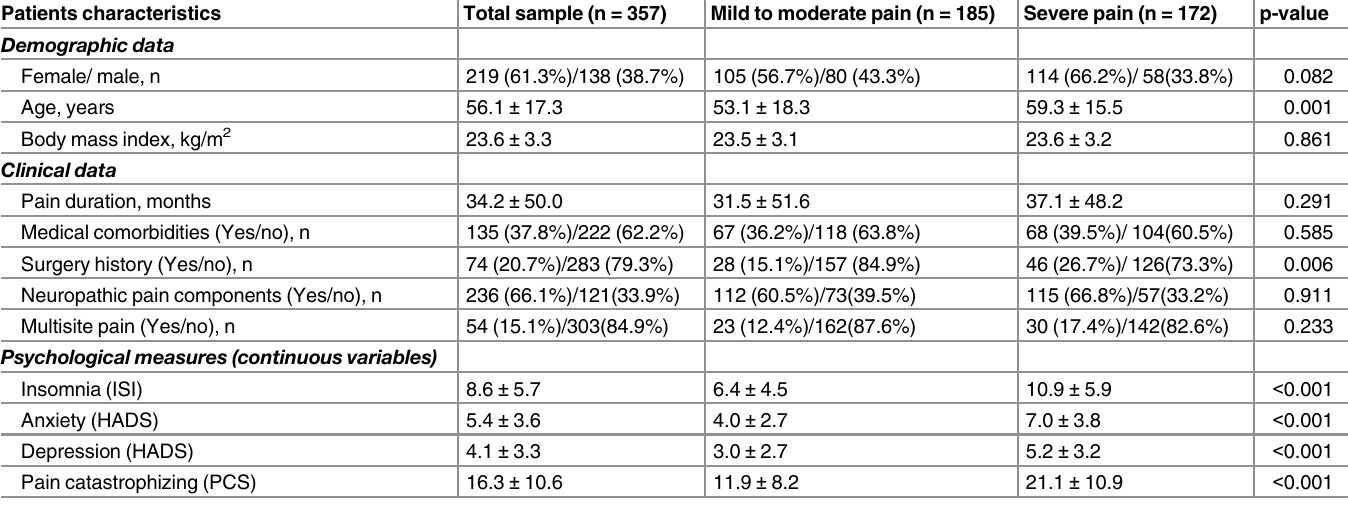
Table 1. Differences between patient groups with mild to moderate pain (NRS < 7) and severe pain (NRS (cid:1) 7) in demographic and clinical character- istics, and psychological measures.